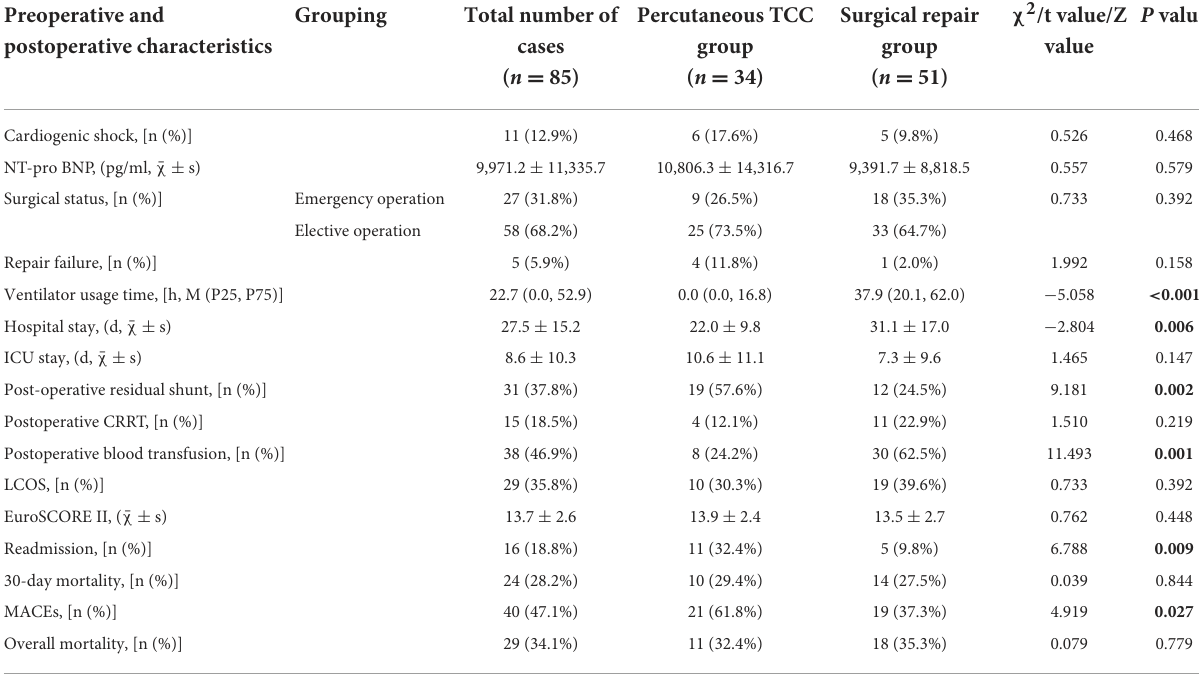
TABLE 5 Comparison of preoperative and postoperative characteristics of VSR patients between surgical repair group and percutaneous TCC group ( n = 85). Preoperative and